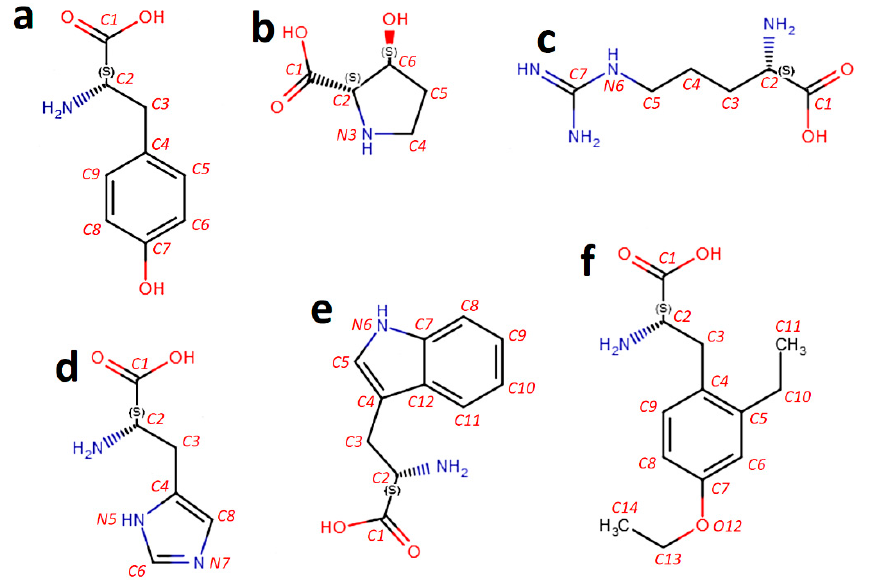
Figure 1. Examples of the continuous numbering of atoms in amino acid molecules: ( a ) tyrosine ((2 S )-2-amino-3-(4-hydroxyphenyl)propanoic acid); ( b ) 3-hydroxyproline ((2 S ,3 S )-3-hydroxypyrrolidine-2-carboxylic acid); ( c ) arginine ((2 S )-2-amino-5-carbamimidamidopentanoic acid); ( d ) histidine ((2 S )-2-amino-3-(1H-imidazol-5-yl)propanoic acid); ( e ) tryptophan ((2 S )-2-amino-3-(1 H -indol-3-yl)propanoic acid); ( f ) (2 S )-2-amino-3-(4-ethoxy-2-ethylphenyl)propanoic acid. Figure prepared using Marvin Sketch editor (Chem Axon, Budapest, Hungary).